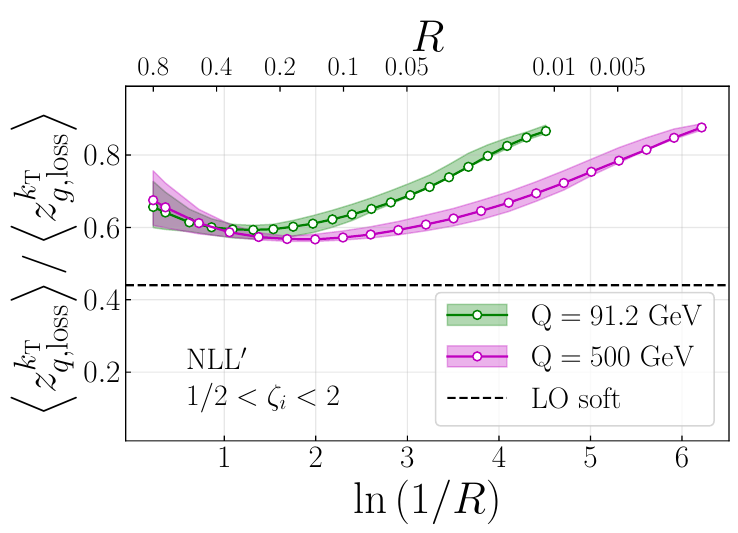
Figure 11 . Ratio of the average quark and gluon jet energy loss as a function of the jet radius R for two different values of the energy scale Q = 91 . 2 GeV and 500 GeV. For comparison, we also show the result at LO in the soft